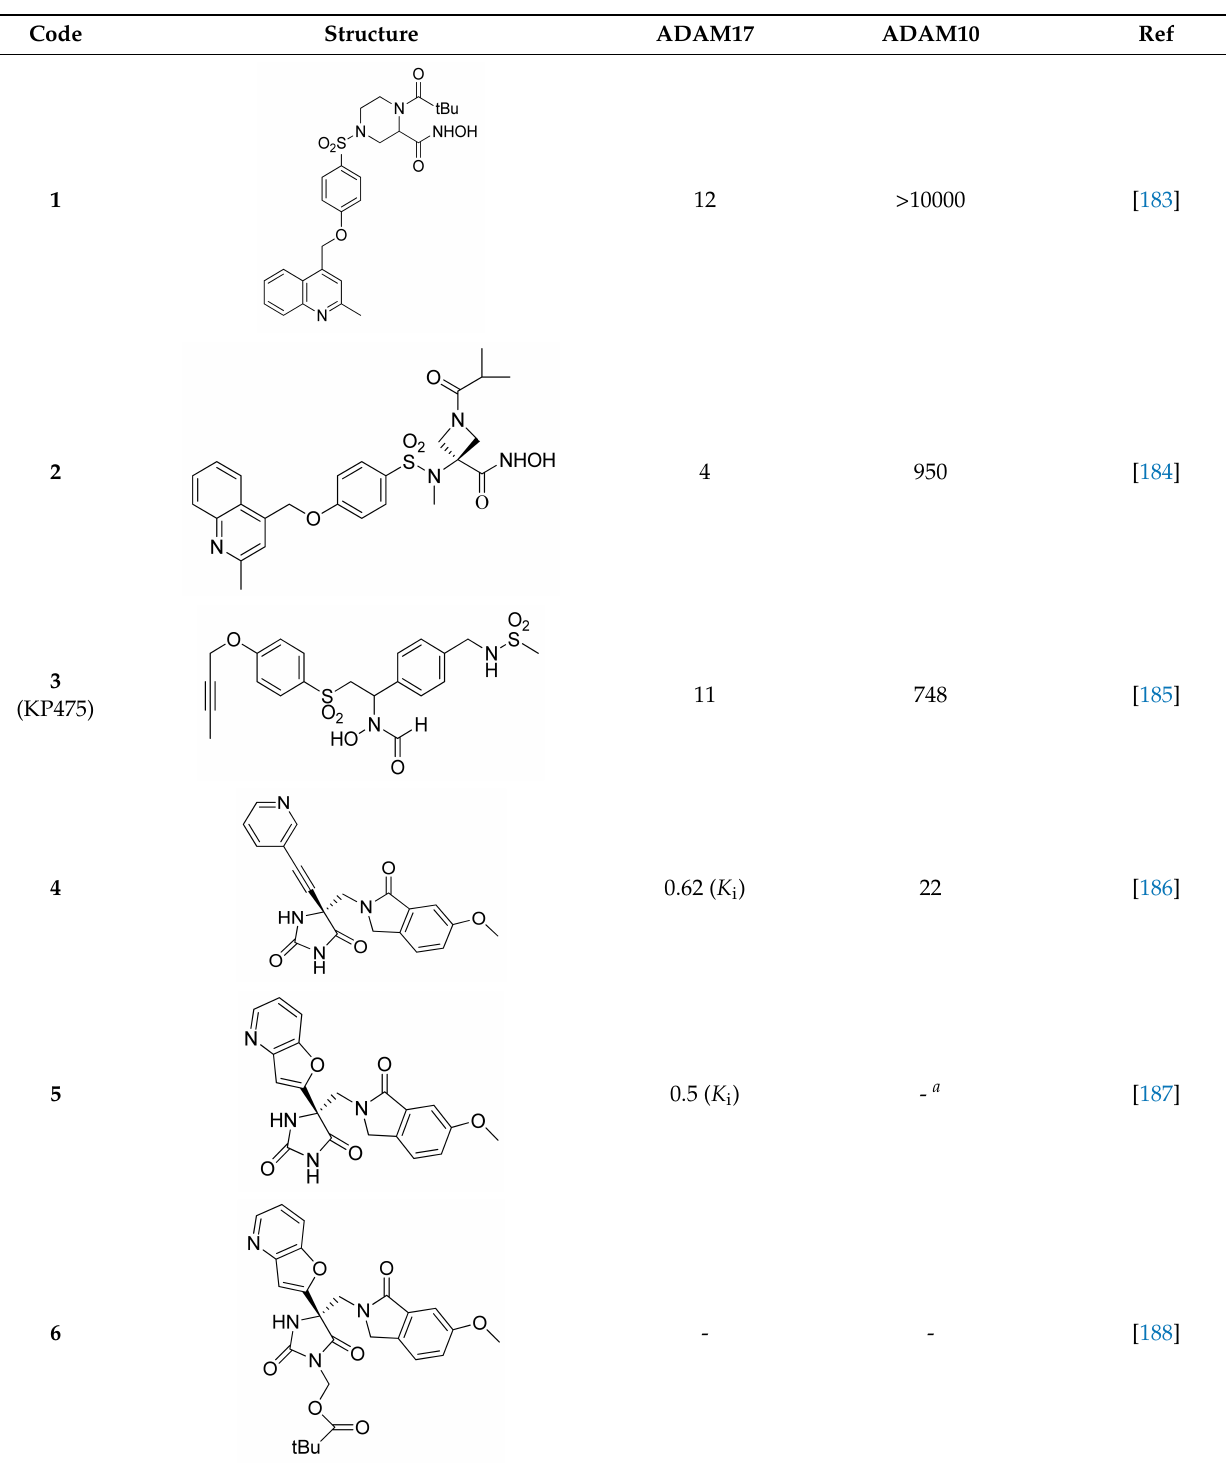
Table 3. Inhibitory activity (IC 50 nM) of selected inhibitors against ADAM17 and